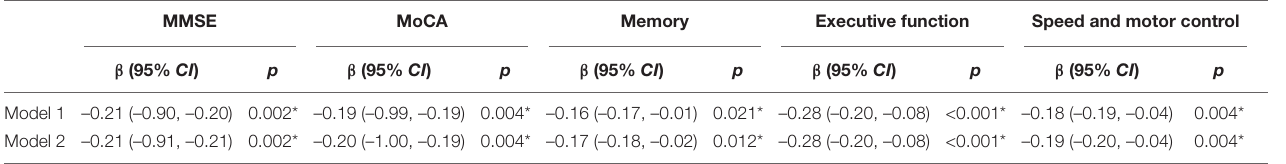
TABLE 6 | Association between total CSVD burden and cognitive domains after propensity score matching. MMSE MoCA